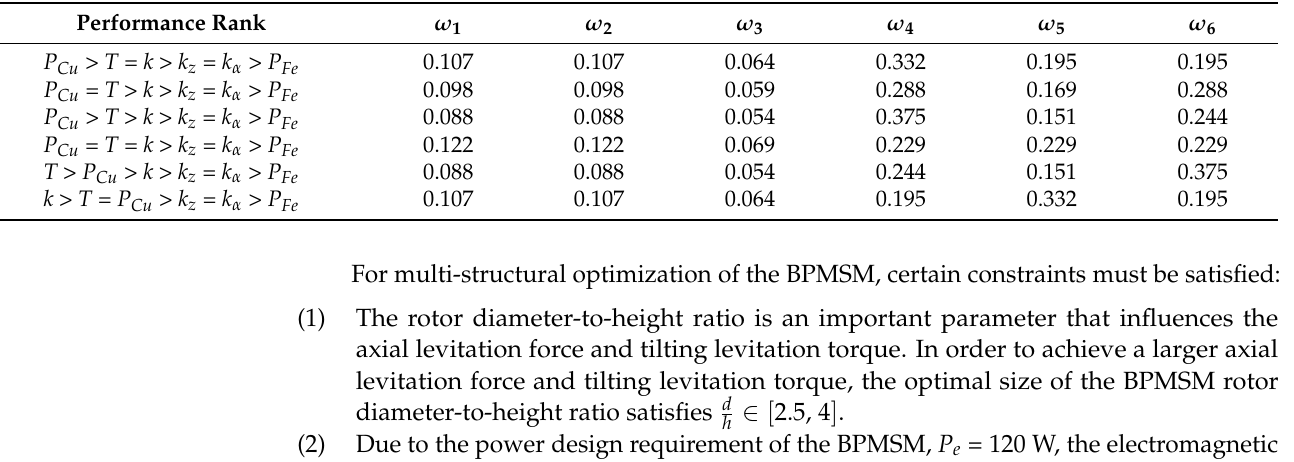
Table 4. The weight coefficients of the multi-structural optimization